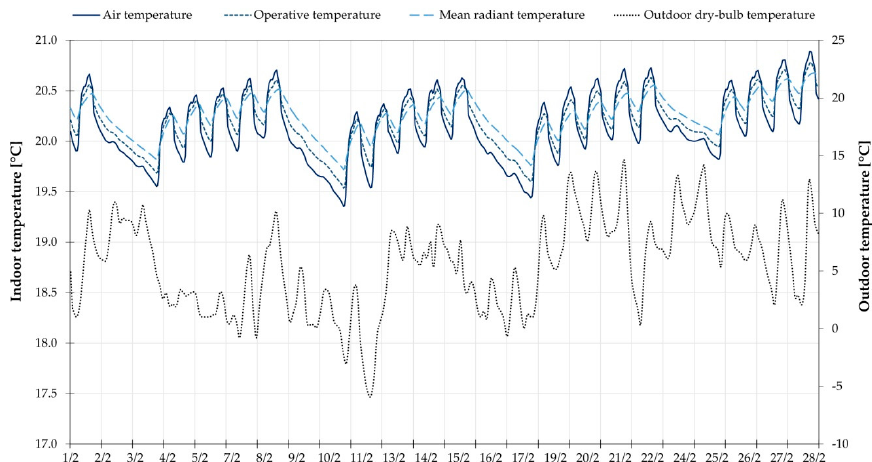
Figure 7. Simulated zone temperatures with respect to outdoor dry-bulb air temperature (February).